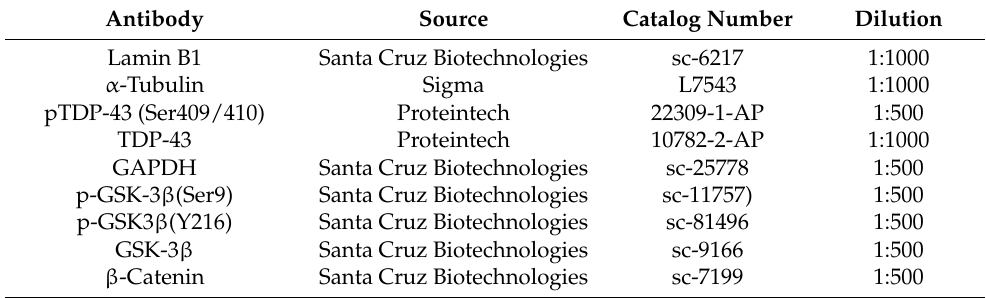
Table 1. List of antibodies used.